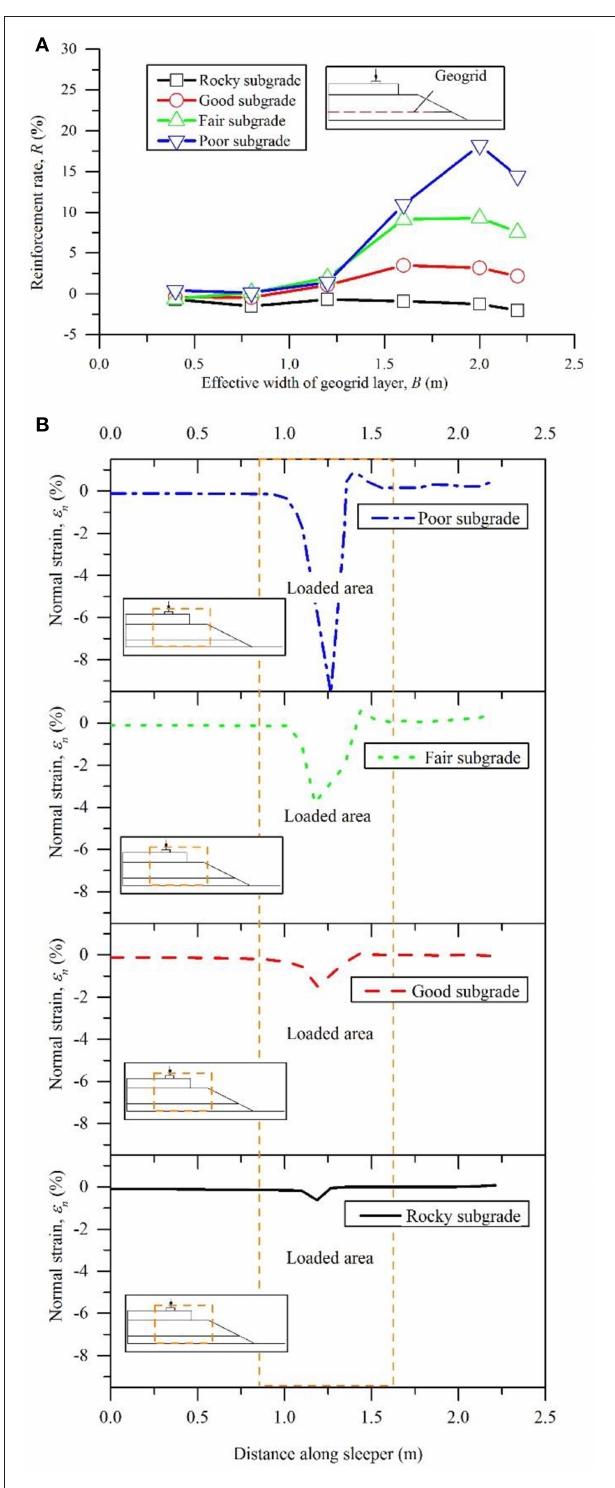
FIGURE 6 | Reinforcement rate of geogrids with respect to the factor of effective width of geogrids (Case 4) and normal strain on the sub-ballast surface in unreinforced models over different subgrades: (A) reinforcement rate; (B) normal strain and loaded area on the sub-ballast surface in unreinforced